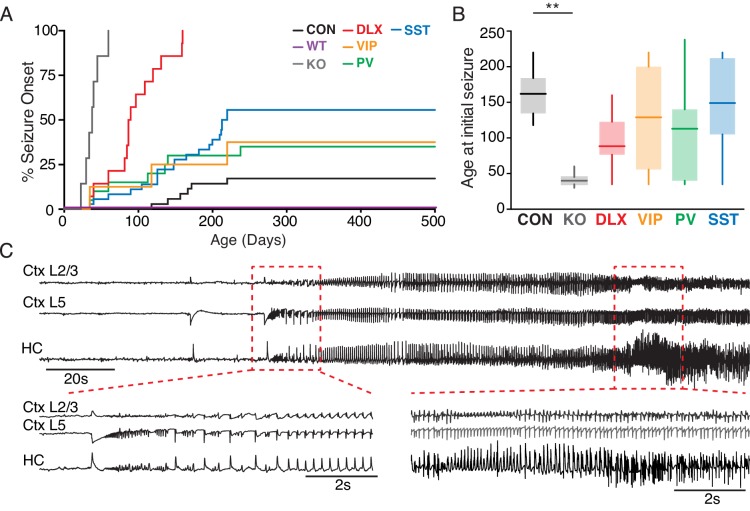
Seizure incidence following conditional deletion of Mecp2 from GABAergic interneurons.(A) Cumulative distribution plot of the ages at which animals exhibited initial seizure activity for Mecp2f/y controls (CON; black; n = 38), wild-types (WT; magenta; n = 10), Mecp2–/y (KO, gray; n = 10), and Dlx5/6 (DLX; red; n = 13), VIP (orange; n = 8), PV (green; n = 22), and SST (cyan; n = 36) mutants. (B) Mean age at initial seizure for Mecp2f/y controls (n = 7) and Mecp2–/y (n = 10), Dlx5/6 (n = 13), VIP (n = 3), PV (n = 7), and SST (n = 19) mutants. (C). Example local field potential recordings from parietal cortical layers 2/3 and 5 and from the CA1 of the hippocampus showing spontaneous ictal activity in an awake SstCre+/–Mecp2 f/y animal at P220. **, p<0.01.